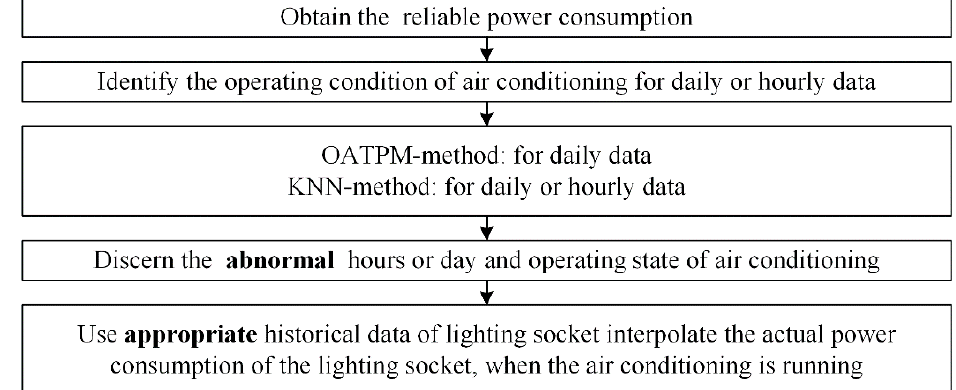
Figure 11. Diagram of the overall model of implementing the identification and separation